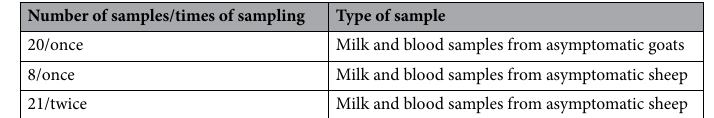
Table 3. Number of unpasteurized milk and blood samples and their animal sources.